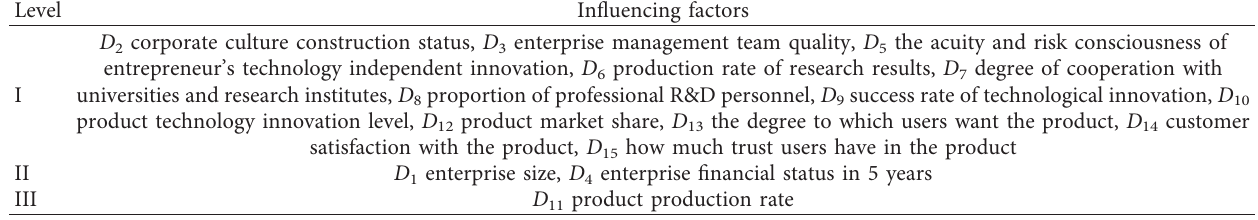
Table 5: Hierarchy of explicit important influencing factors for the realization of technological independent innovation in equipment manufacturing enterprises.